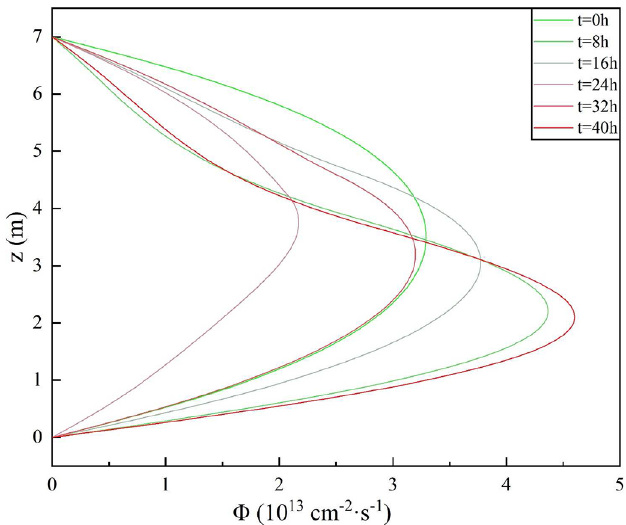
Fig. 12. Evolution of the thermal fl ux distribution. The colour code is from green (initially) to red ( fi nal